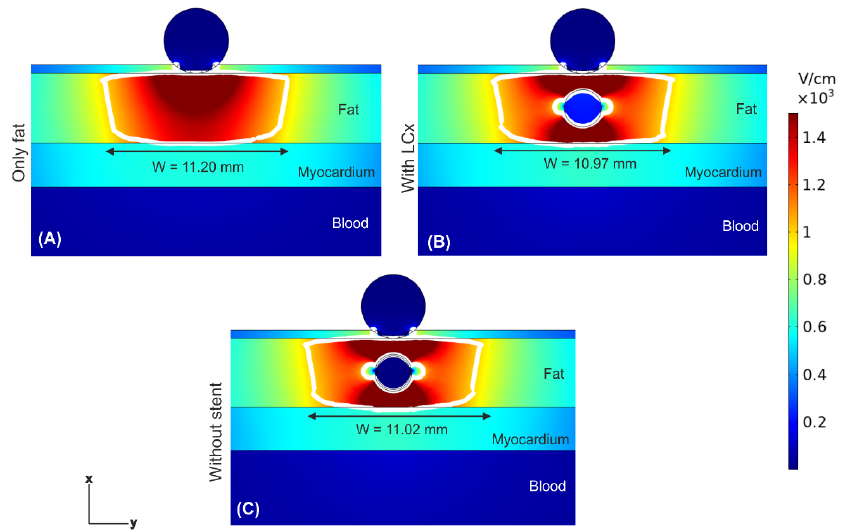
Figure 4. Electric field distributions after a train of ten PEF pulses (100 µ s between them) for a distance of 1 mm between ablation electrode and artery/stent. Different scenarios were compared: ( A ) epicardial fat layer without artery, ( B ) artery without stent, and ( C ) artery with stent. The white contour corresponds to the 1000 V/cm electric field isoline and defines the PEF-zone.